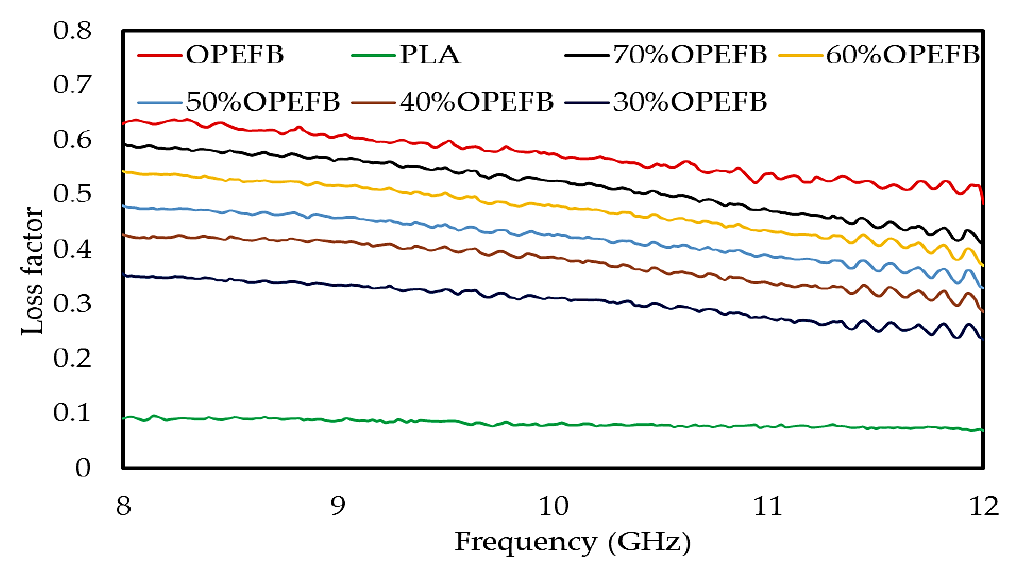
Figure 9. Variation in loss factor of OPEFB/PLA composites at different percentages of OPEFB